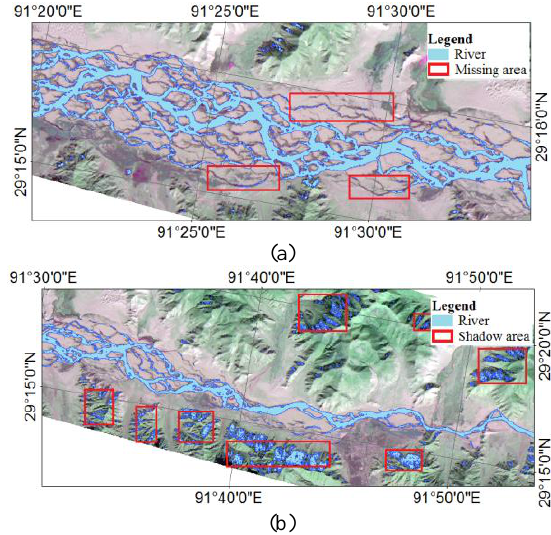
Figure 8. Error types in river extraction process (a) Missing river area (b) Wrong shadow area